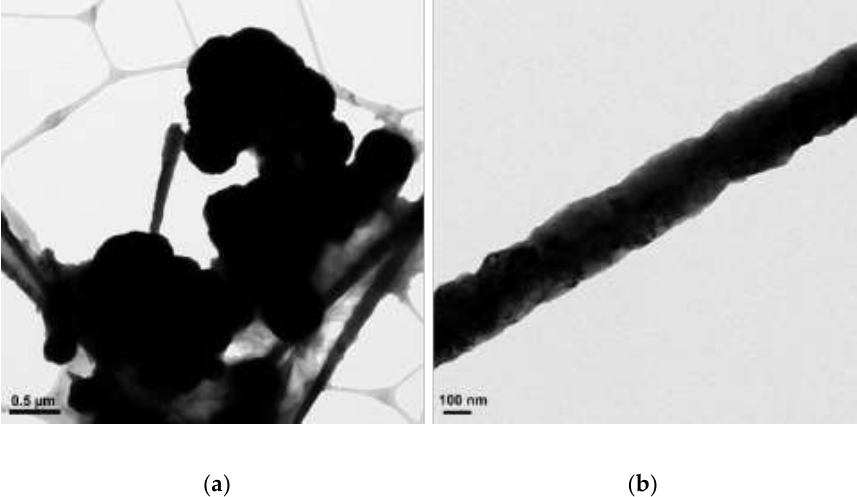
Figure 2. TEM images of copper products at 40 ◦ C: ( a ) scale bar 0.5 µ m; ( b ) scale bar 100 nm.